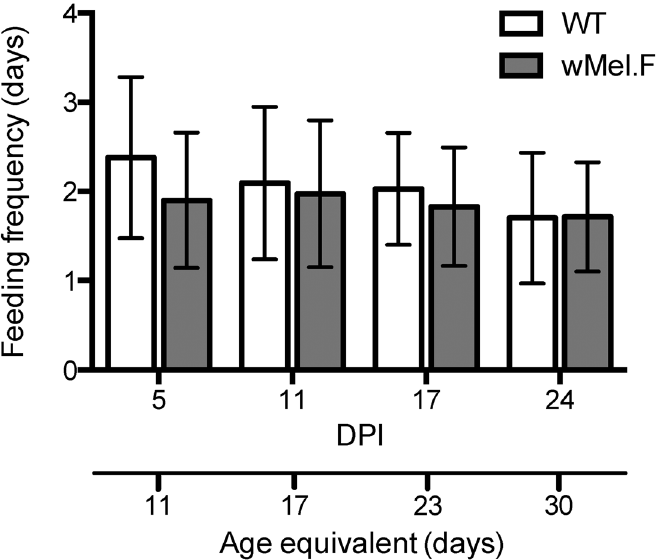
Fig 7. Comparison of sucrose feeding frequency of WT (white) and w Mel.F mosquitoes (grey) at four different ages. Bars depict means ± S.E.M. Number of replicates range from 26 to 40 with a mean of 37 individuals for WT mosquitoes and 20 to 40 with a mean of 35 for w Mel.F mosquitoes across all time points. 80.1% of all the mosquitoes produced feeding frequency